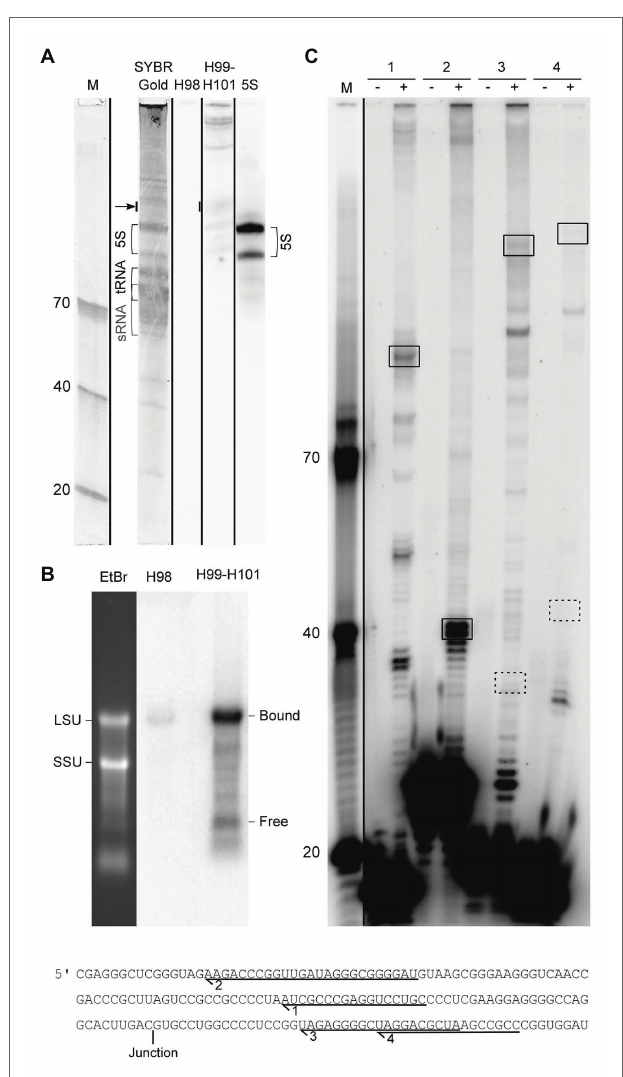
FIGURE 4 | Experimental analysis of LSU rRNA circularization and H98 removal. (A) Northern blot analysis of the small RNA fraction of whole cell RNA fractionated on a 10% UPAG. The DNA oligonucleotide size marker (M) is followed by a SYBR Gold stained lane with indications of sRNA, tRNA, and 5S rRNA, followed by parallel hybridizations using probes against H98, H99–H101, and 5S rRNA (control). The lanes are separated by black lines to indicate that they were parallel lanes from the same gel. The arrow indicates the signal that was used to estimate the substoichiometric (compared to 5S rRNA) amounts of free 3 ´ terminal LSU rRNA fragment (129 nt; comprising H99-H101). The two forms of 5S rRNA detected may represent the two copies of the